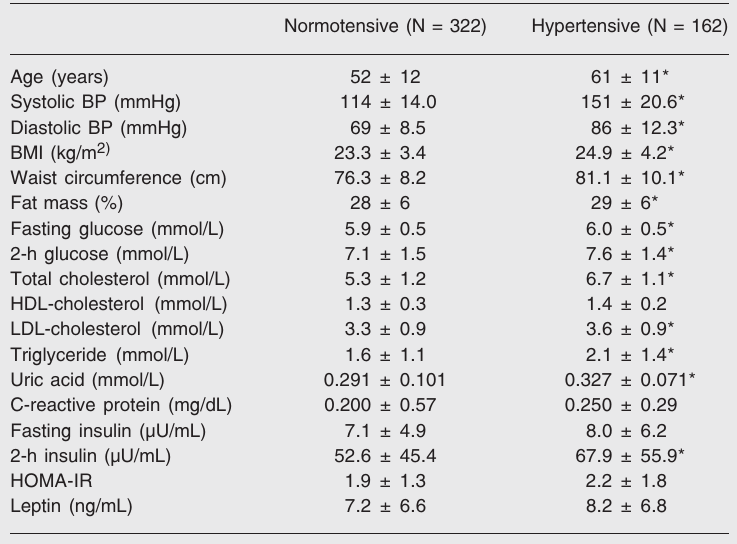
Table 1. Main characteristics of nondiabetic Japanese-Brazilians according to the presence of hypertension.